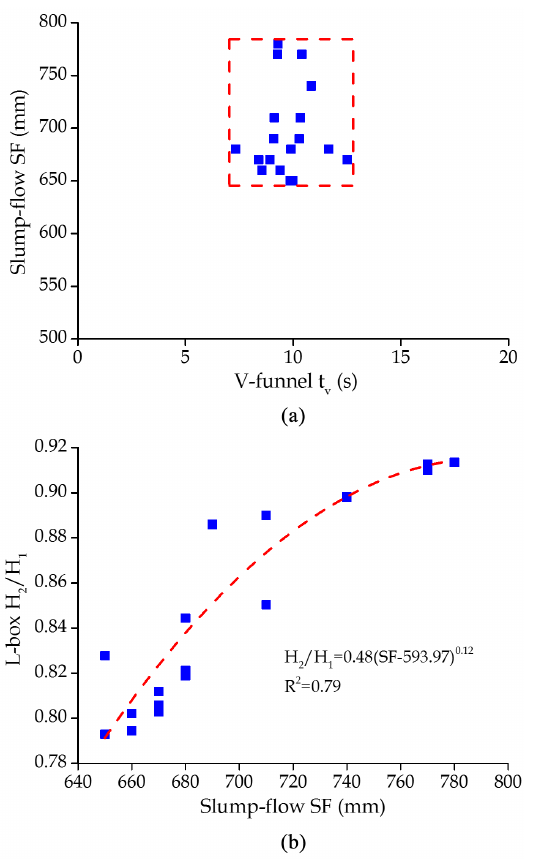
Figure 8. 7, 28, 91 and 182-day compressive strength of binary and ternary